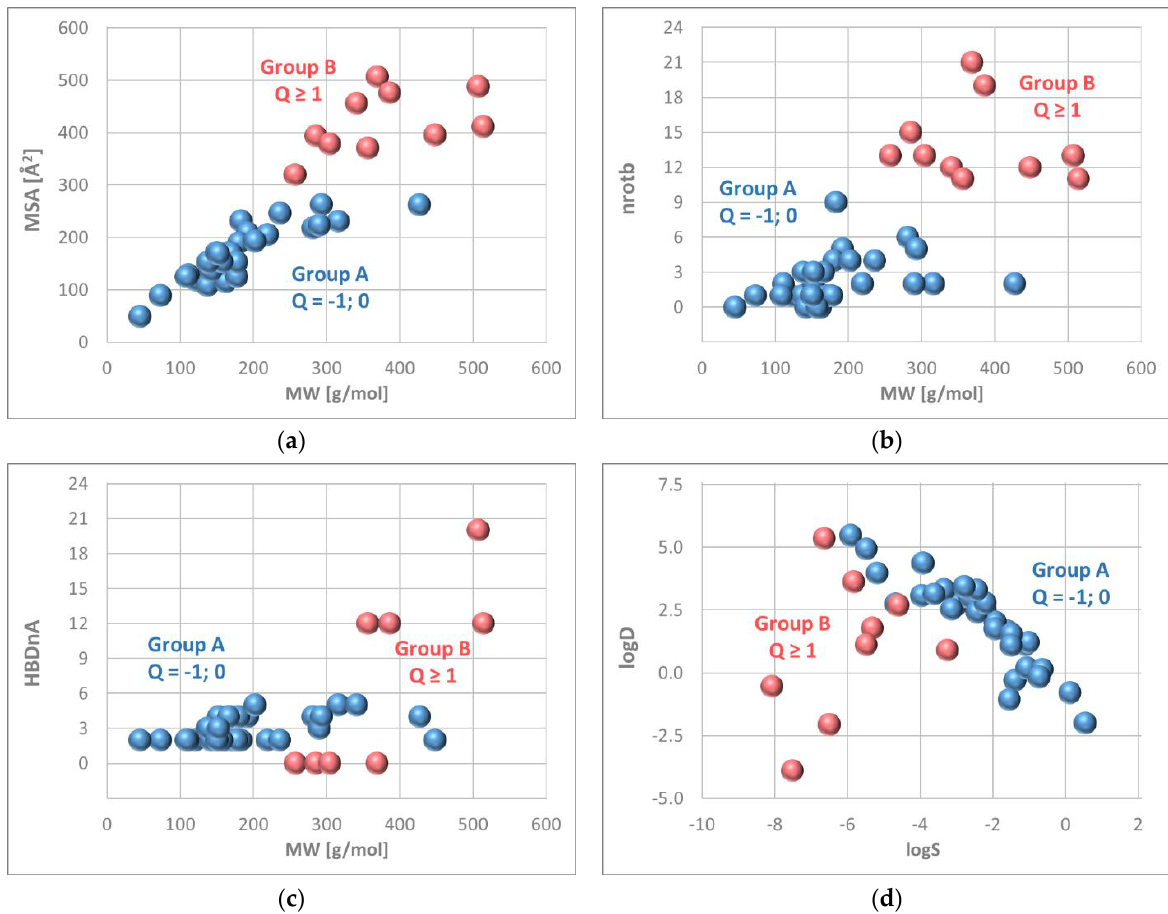
Figure 2. Two-dimensional plots including position of neutral or anionic (blue) and cationic (red) preservatives in chemical space: ( a ) plot of Connolly molecular surface area (MSA) vs. molecular weight (MW) as easily available alternative measure of size; ( b ) plot of number of rotatable bonds (nrotb) vs. MW; ( c ) plot of hydrogen bonding capacity (HBDnA) vs. MW; ( d ) plot of distribution coefficient (logD) vs. aqueous solubility (logS).